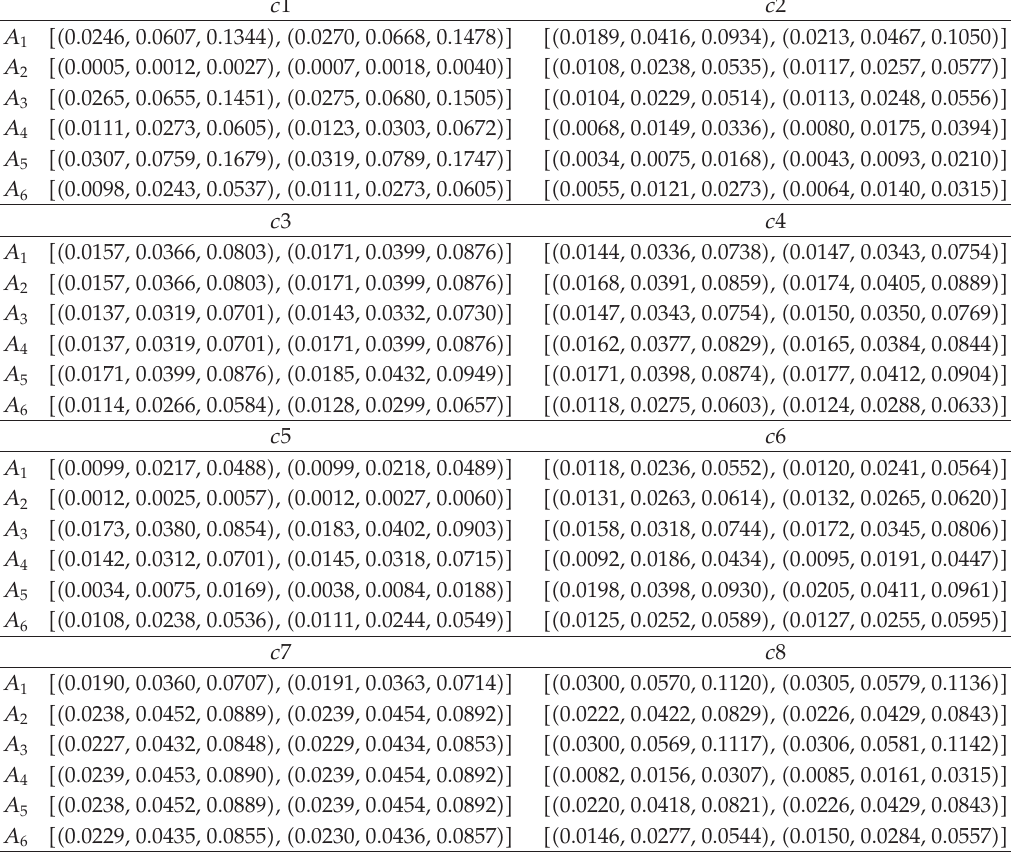
Table 8: A weighted fuzzy normalized decision matrix. c 1 c 2